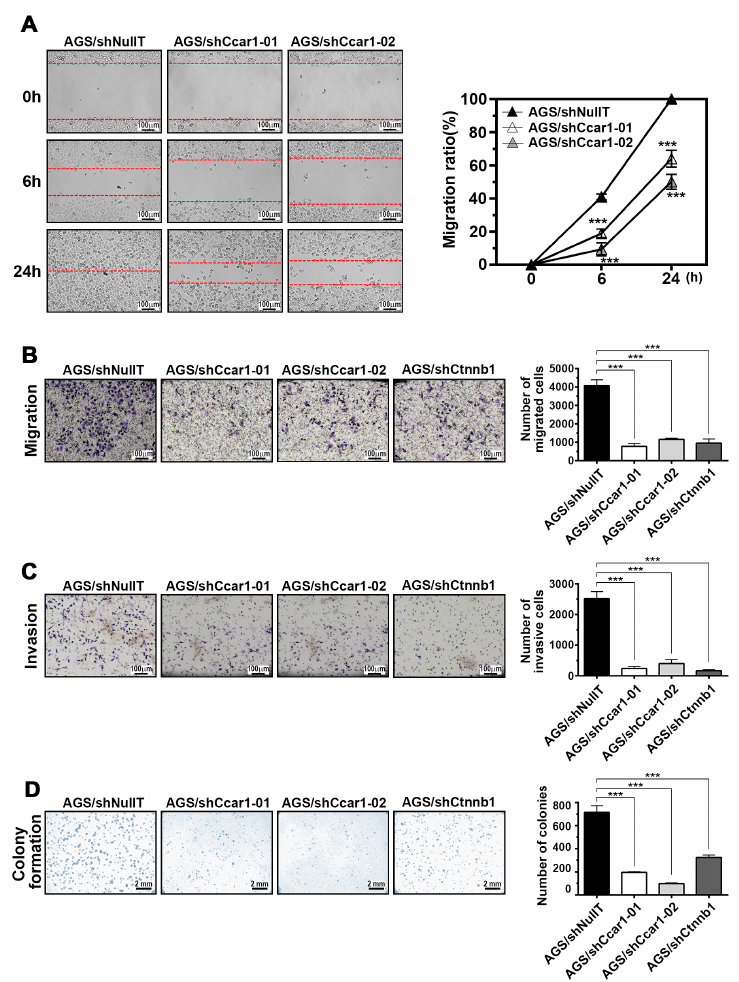
Figure 3. CCAR1 regulates cancer cell migration and invasion. The changes of cell colony formation, migration, and invasion ability affected by infected with CCAR1-specific shRNA lentiviruses were determined by the wound healing assay ( A ); transwell migration assay (without Matrigel) ( B ); invasion assay (with Matrigel) ( C ); and colony formation assay ( D ). Data are presented as the mean with error bars representing the S.D. (*** p < 0.001).